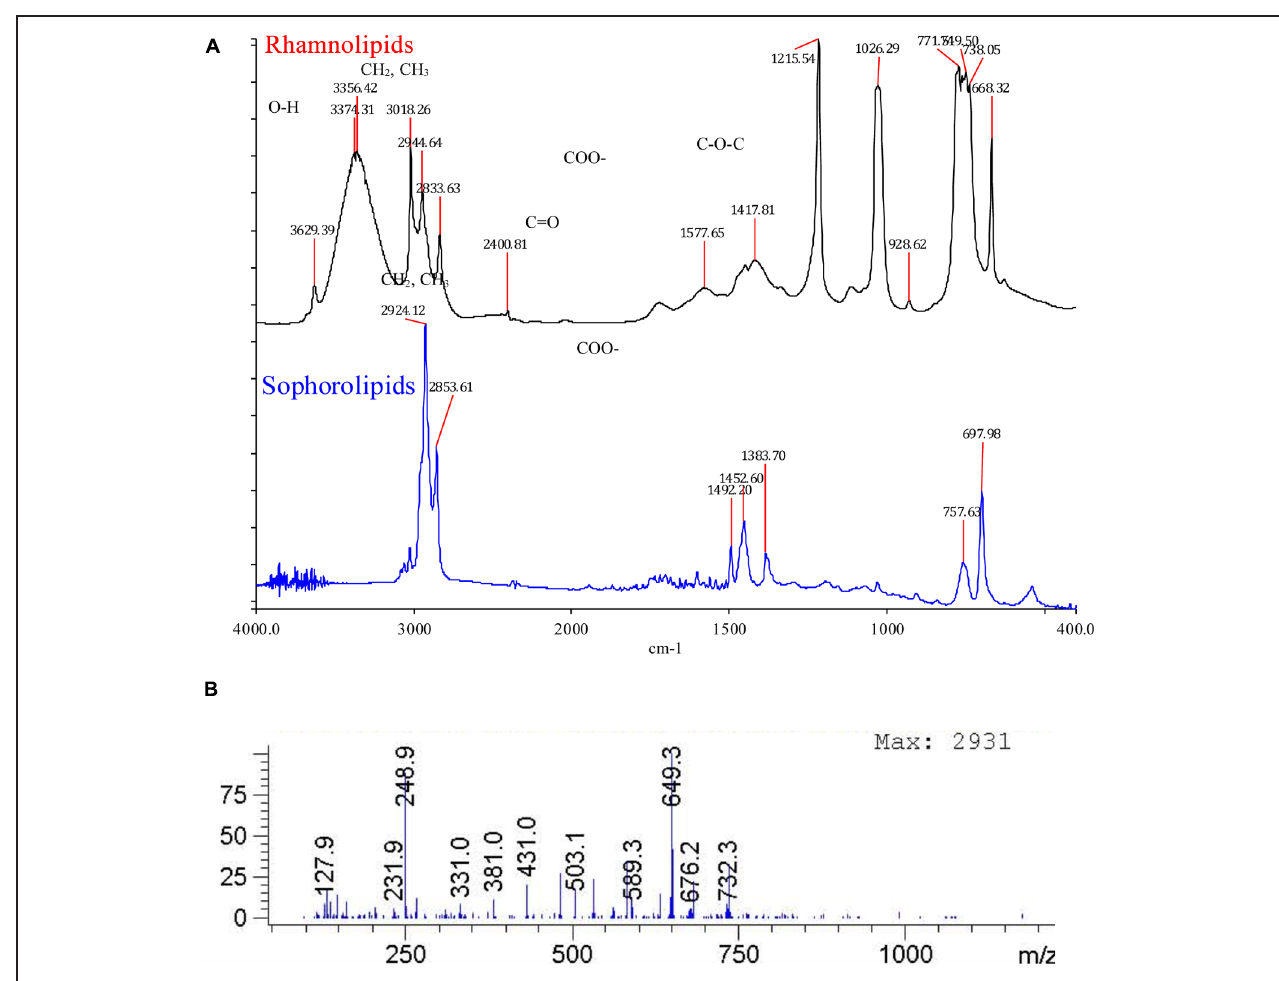
FIGURE 8 | (A) Fourier transform infrared (FT-IR) spectrum of isolated rhamnolipids and sophorolipids. The characteristic peaks at 2930 (CH 2 , CH 3 ), 2830–2850 (CH 2 , CH 3 ), 1725 (C = O), 1450 (COO − ), 1300-1100 confirm the presence of glycolipid type biosurfactant. (B) Rhamnolipids Rha-Rha-C10-C10 and Rha-C10-C10 detected with pseudomolecular ion being 649 and 503